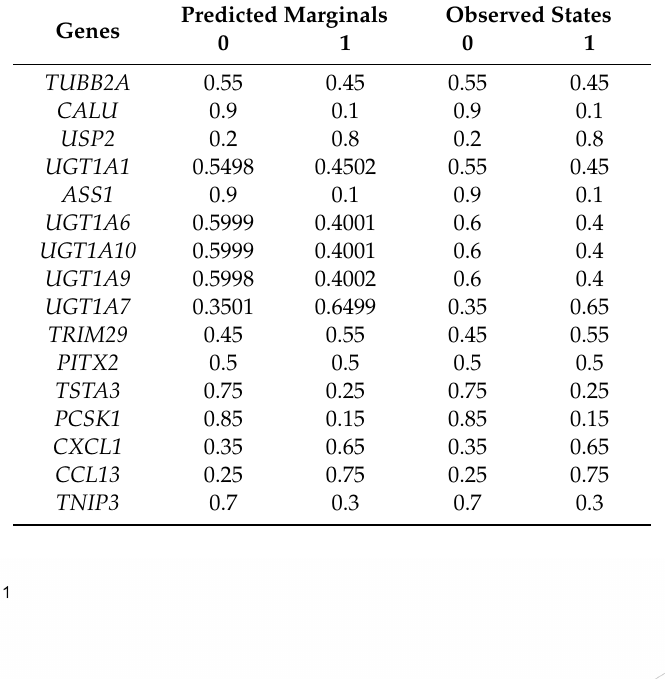
Table 2. Distribution of the posteriors versus observed experimental states for the IBD dataset.